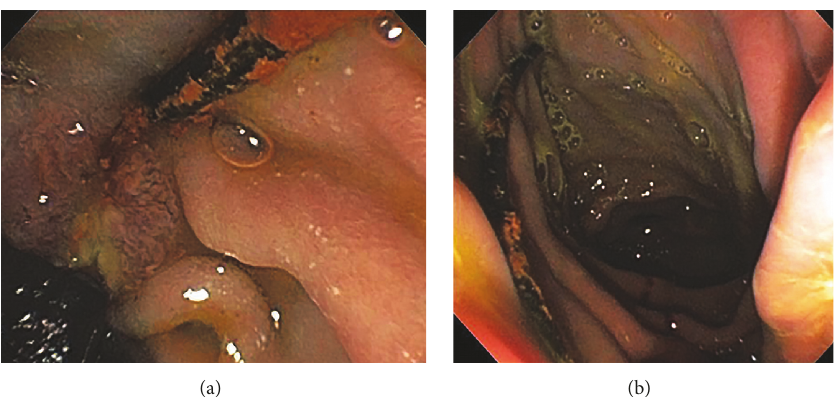
Figure 3: (a)ERC showing blackpediatric feeding tubewith overlying biofilm protruding from thepapilla. (b) ERC with successfulextraction of black pediatric feeding tube from the papilla.